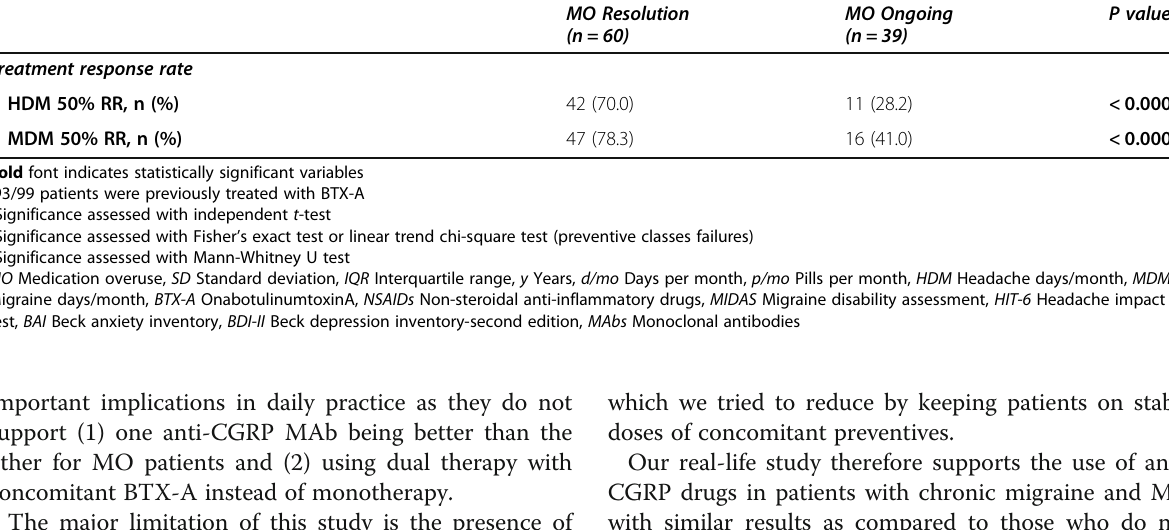
MO Resolution MO Ongoing (n = 60) (n = 39)